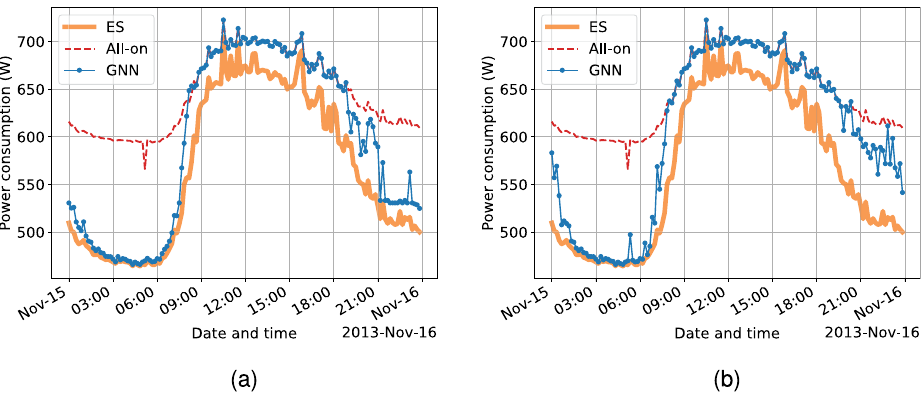
Figure 6. One-day power consumption results for the GNN’s node size generalization test, with models trained using two different node sizes tested with N sc = 12 . ( a ) N sc = 4 for training. ( b ) N sc = 32 for